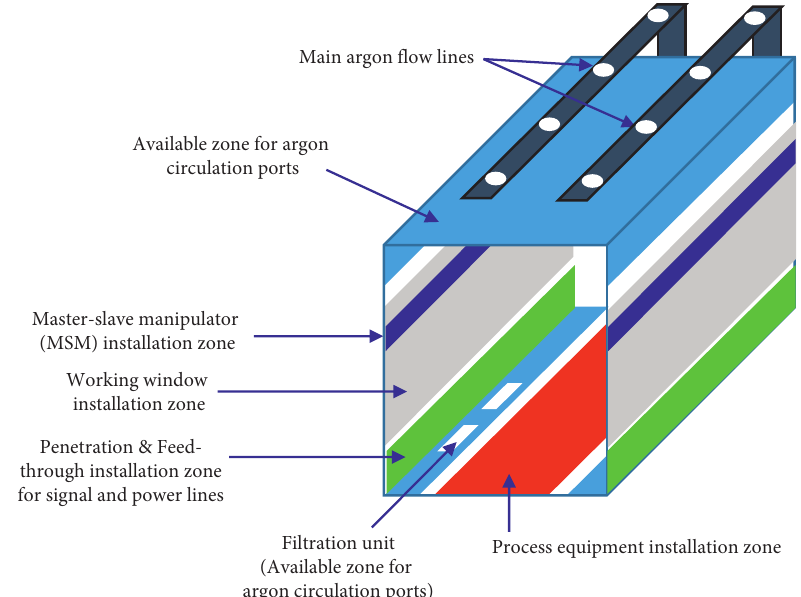
Figure 5: Configuration of argon cell of PRIDE